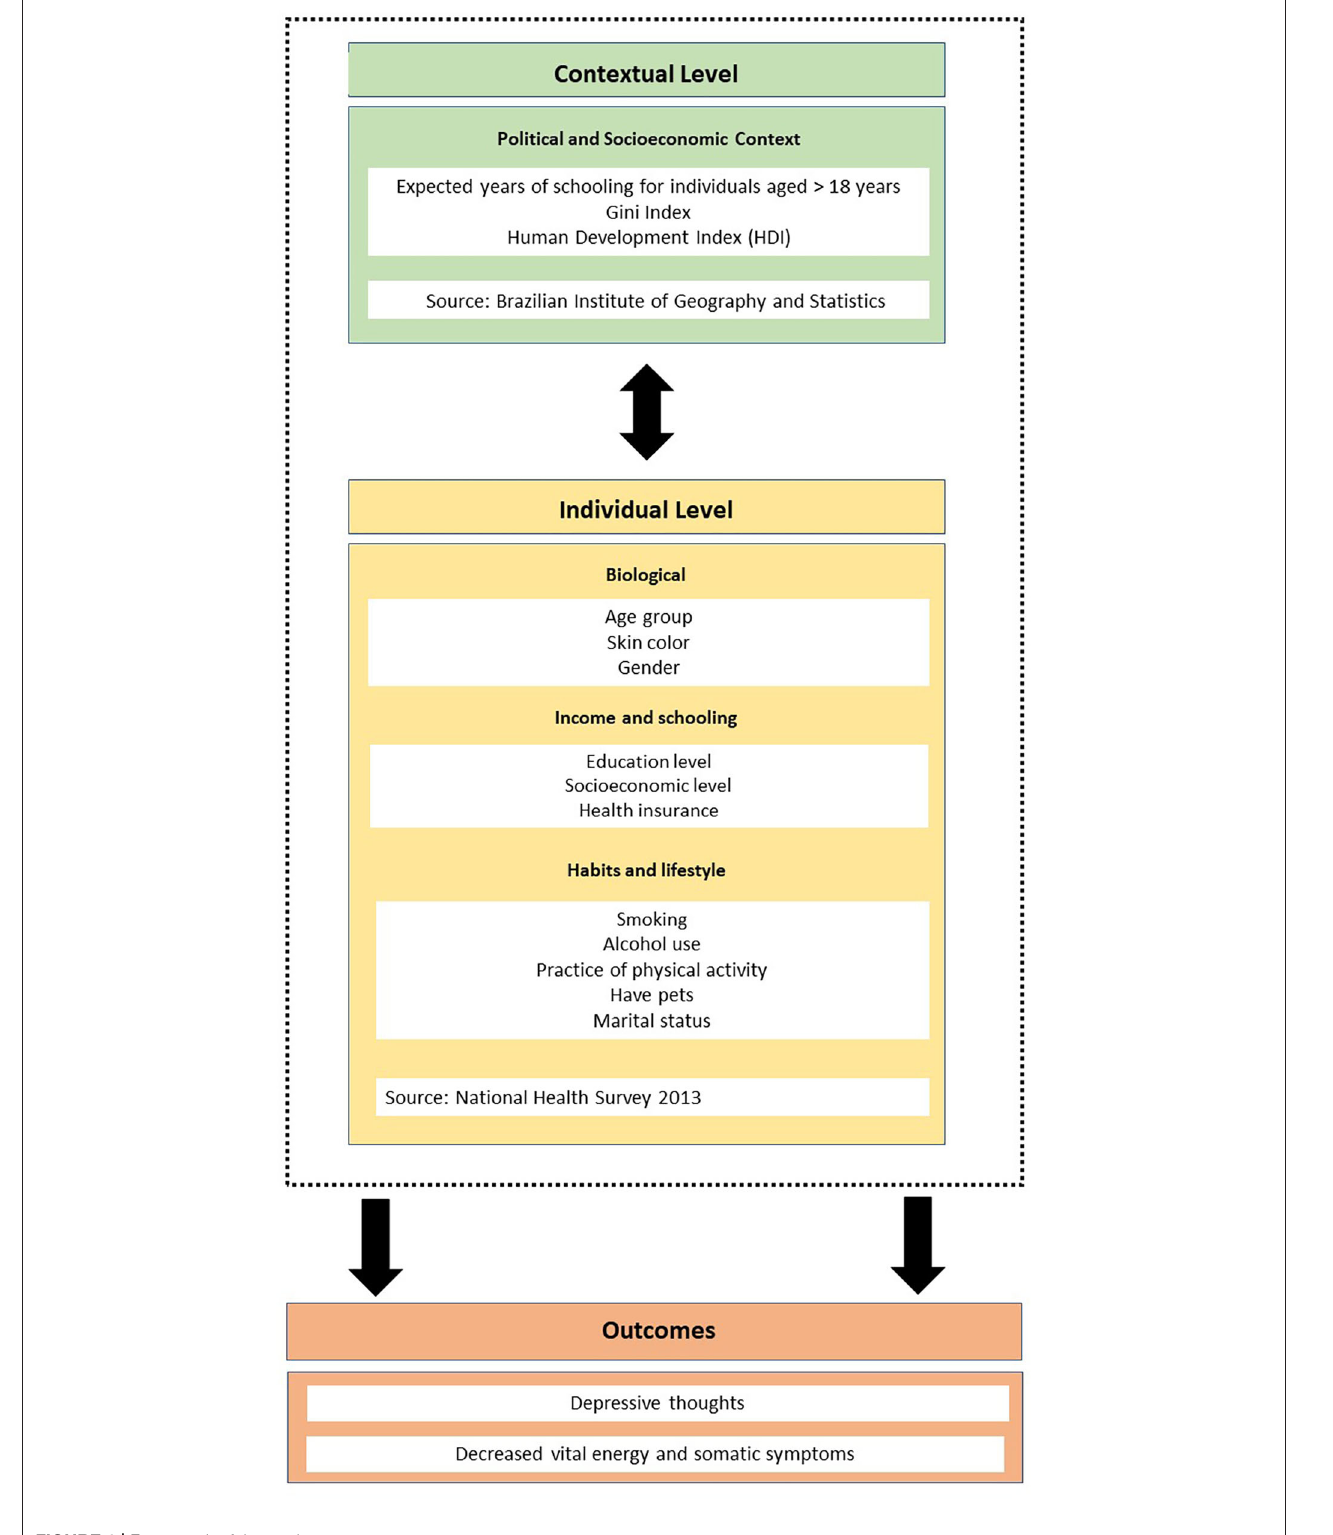
FIGURE 1 | Framework of the